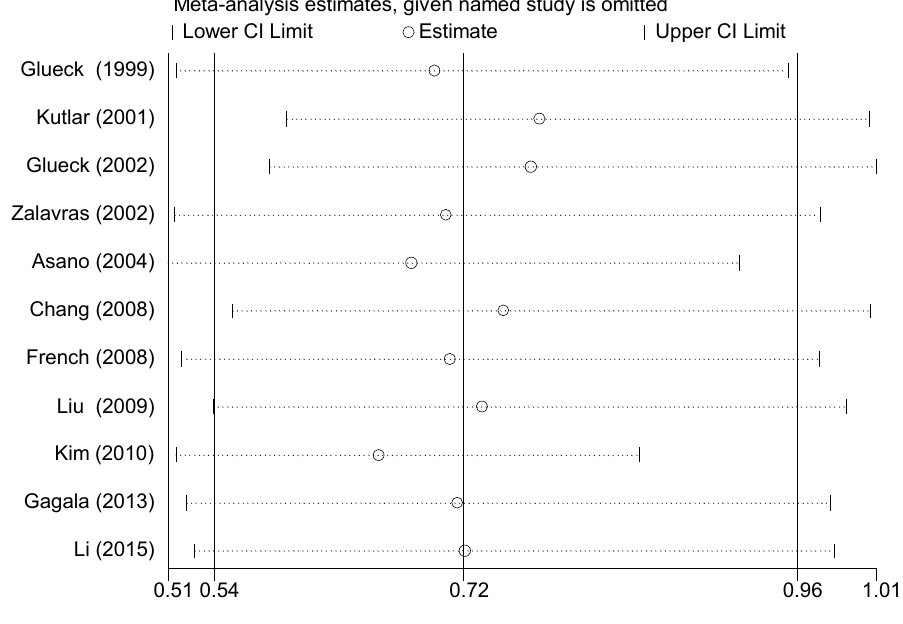
Figure 4: Sensitivity analysis of pooled results was performed by omitting each of the included study.